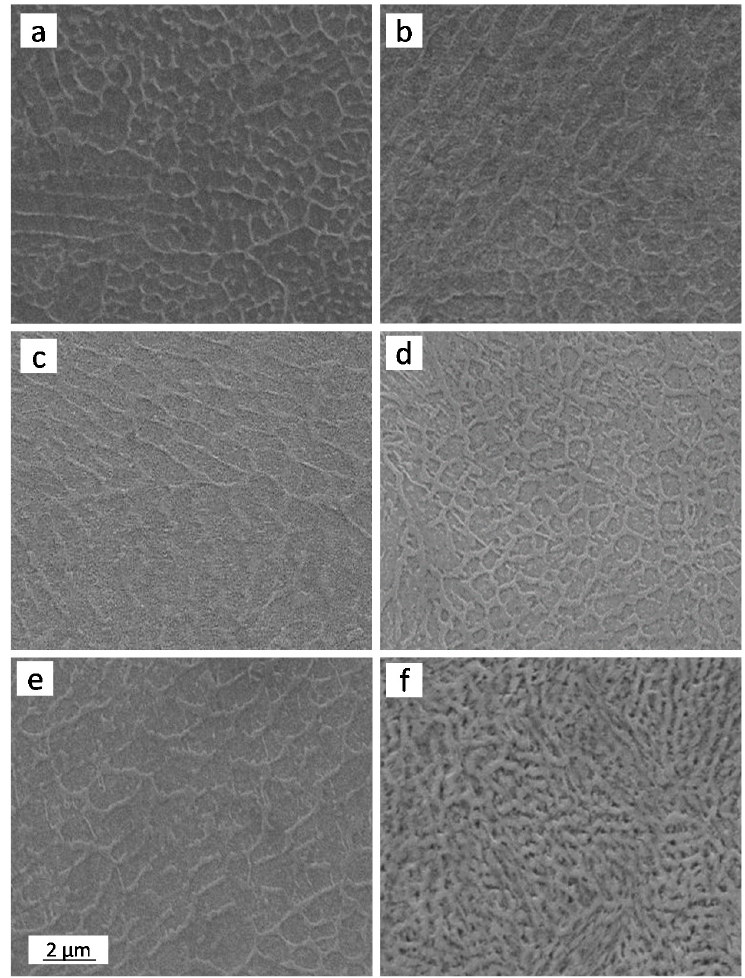
Figure 9. Microstructure (top view) of SLM processed 18-Ni 300 alloy samples aged at different temperatures and times. ( a ) 460 °C 8 h; ( b ) 490 °C 4 h; ( c ) 540 °C 1 h; ( d ) 540 °C 8 h; ( e ) 600 °C 10 min; and ( f ) 600 °C 4 h. Metals 2016 , 6 , 218